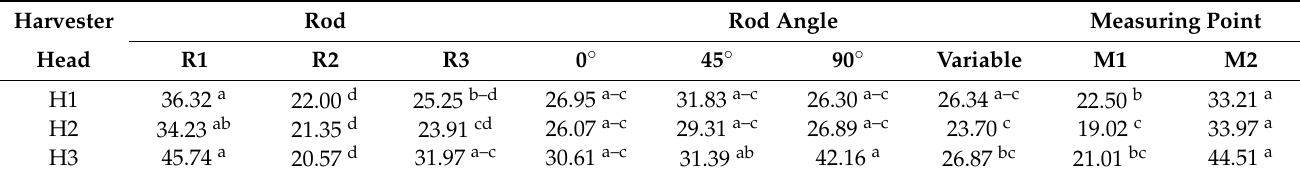
Table 5. Acceleration total values (m/s 2 ) with harvester heads H1-H3 (mean separation by Kruskal–Wallis test for each interaction: means with the same letter are not statistically different at p = 0.05